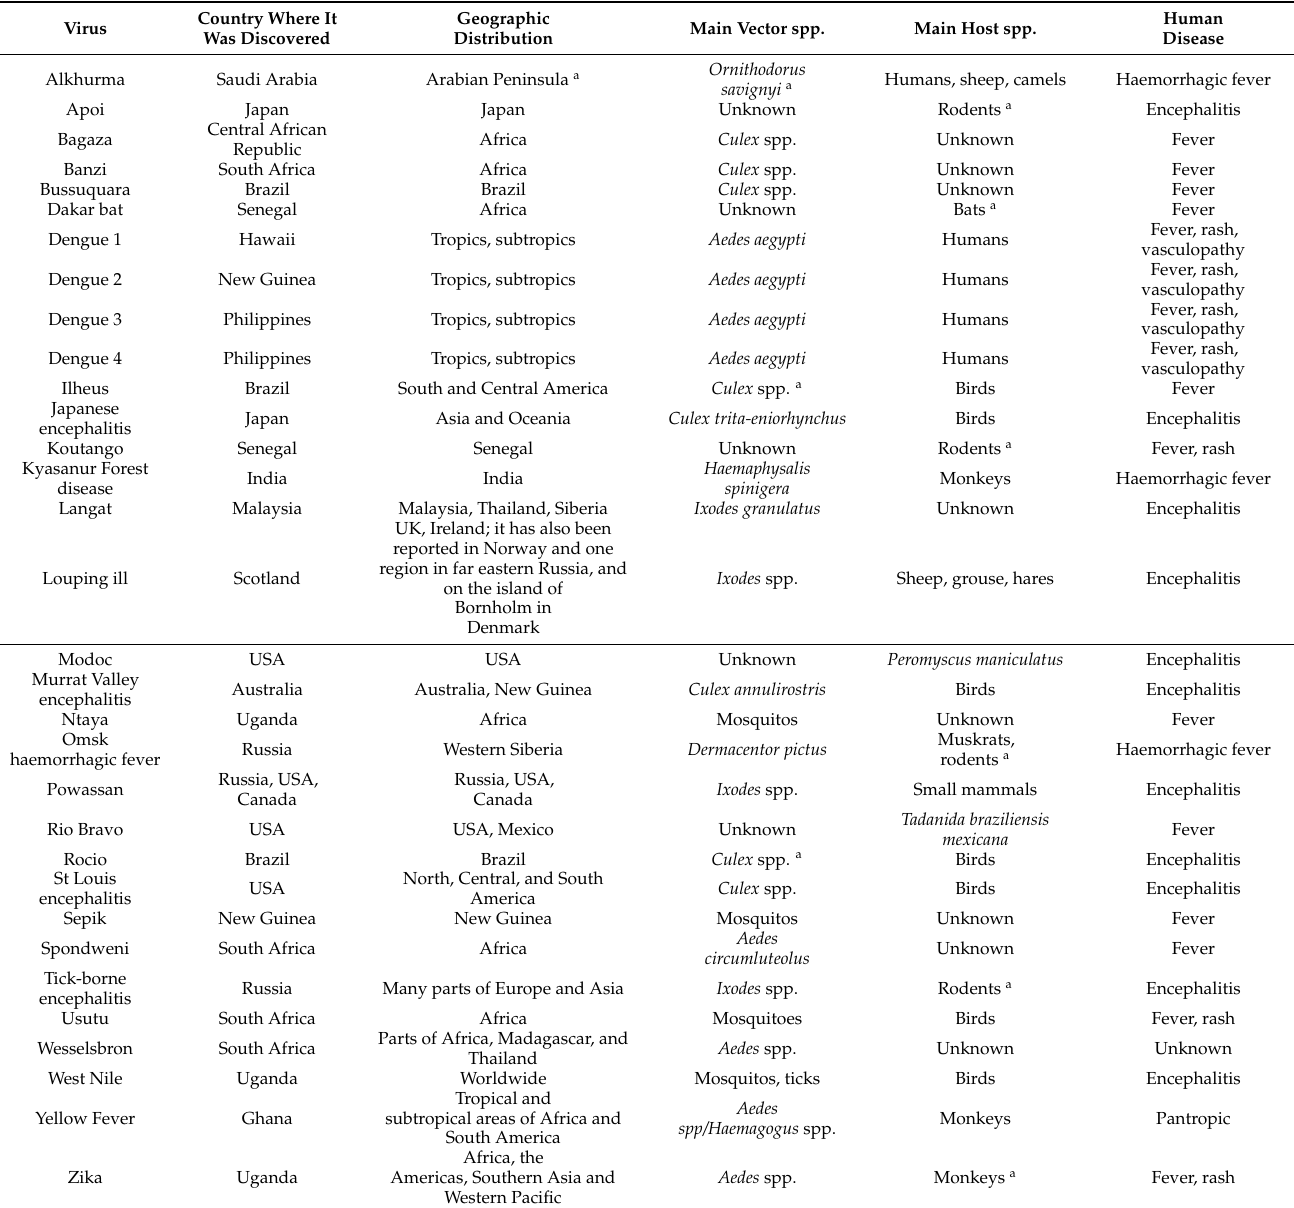
Table 2. Main ecological characteristics and geographic distribution of human pathogenic flaviviruses. Adapted from